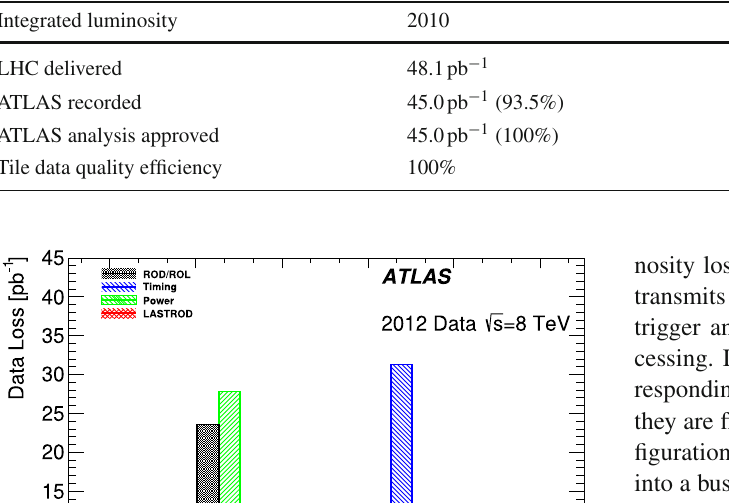
Table 2 Summary of total integrated luminosity delivered by the LHC, recorded by ATLAS and approved for physics analyses (the data qual- ity deemed as good simultaneously from all ATLAS subsystems). The numbers in the parentheses denote the fraction of the integrated lumi-